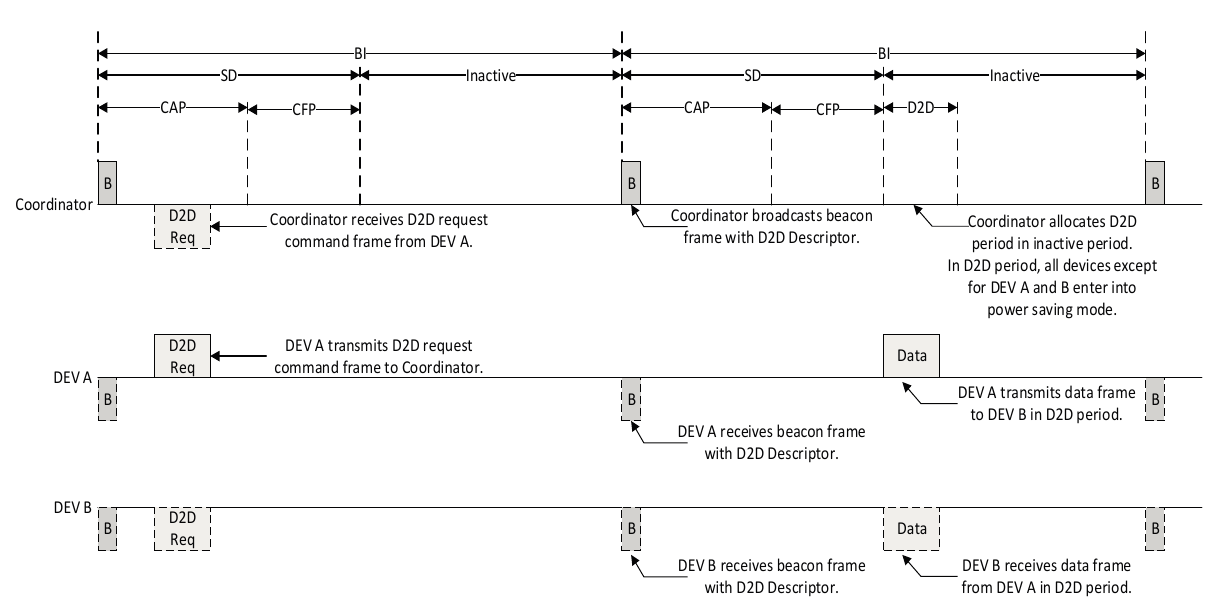
Figure 11. Message sequence chart for D2D deallocation initiated by a coordinator.